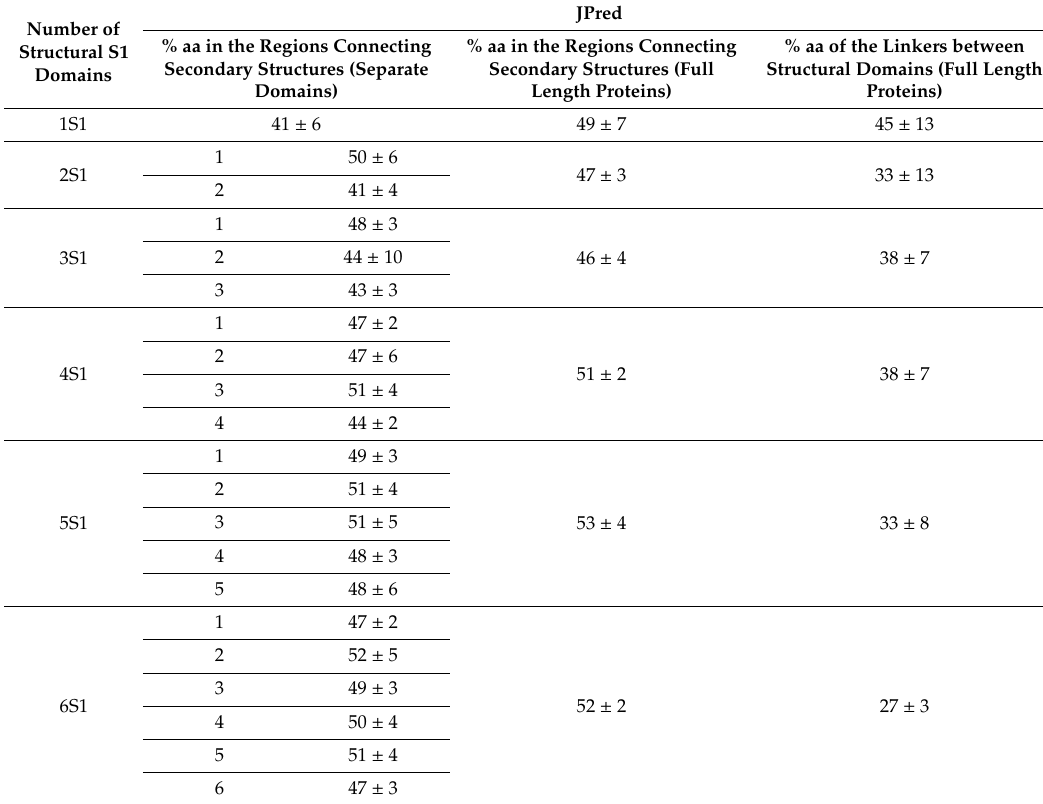
Table 3. Ratio of regions connecting elements of the secondary structure according to the JPred